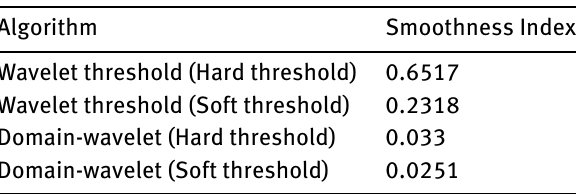
Table 2: The smoothness index of the de-noised differential pres- sure